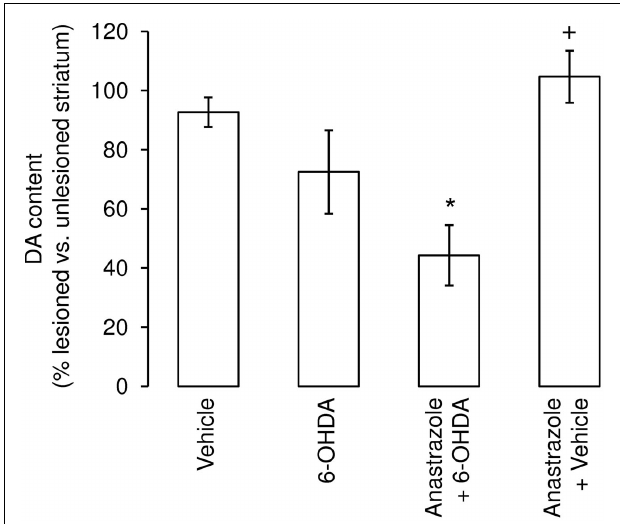
FIGURE 3 | Inhibition of striatal aromatase activity augments the lesion size following administration of 6-hydroxydopamine (6-OHDA). Administration of the selective aromatase inhibitor anastrozole (7 μ g) to the left medial forebrain bundle of male rats concurrently with 1 μ g